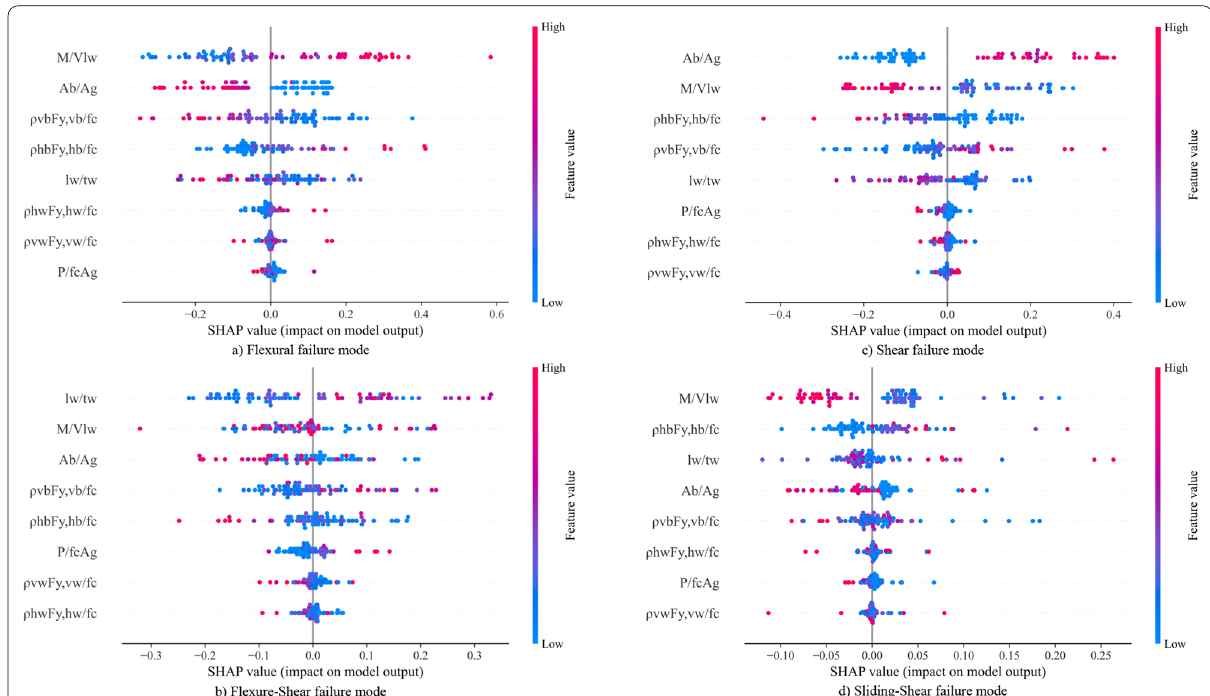
Fig. 12 Summary plot for each class. a Flexural failure mode. b Flexure–shear failure mode. c Shear failure mode. d Sliding-shear failure